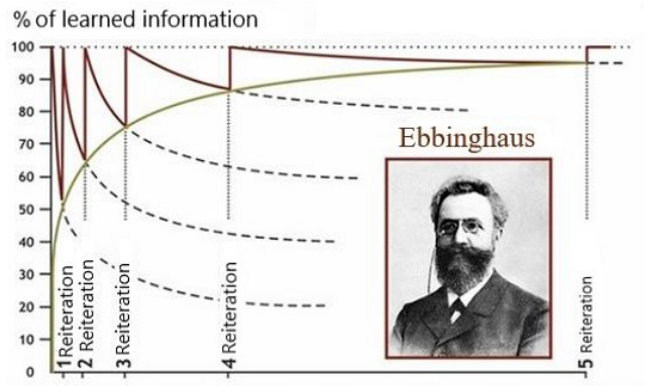
Fig. 4. Ebbinghaus Forgetting Curve.